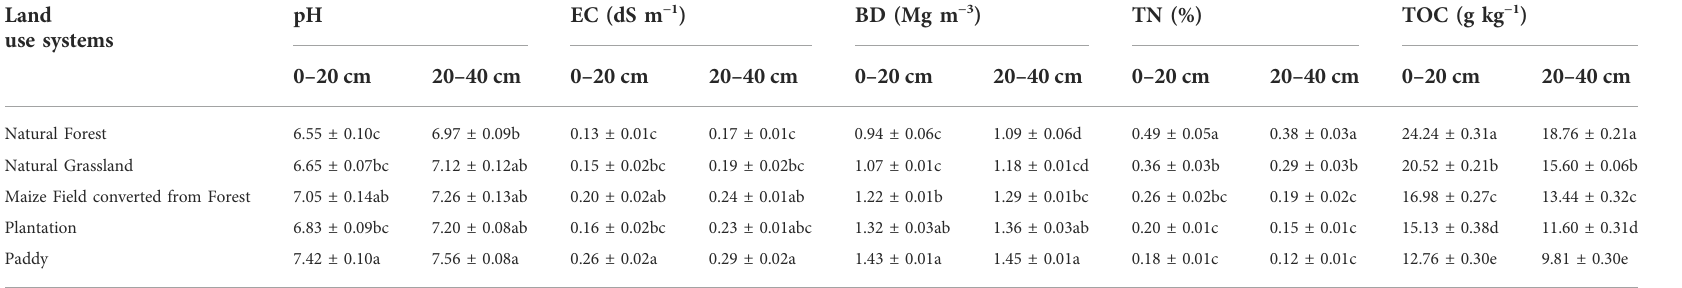
TABLE 1 Soil pH, EC, BD, TN, and TOC in surface and sub-surface soil under diverse land-use systems. Land use systems